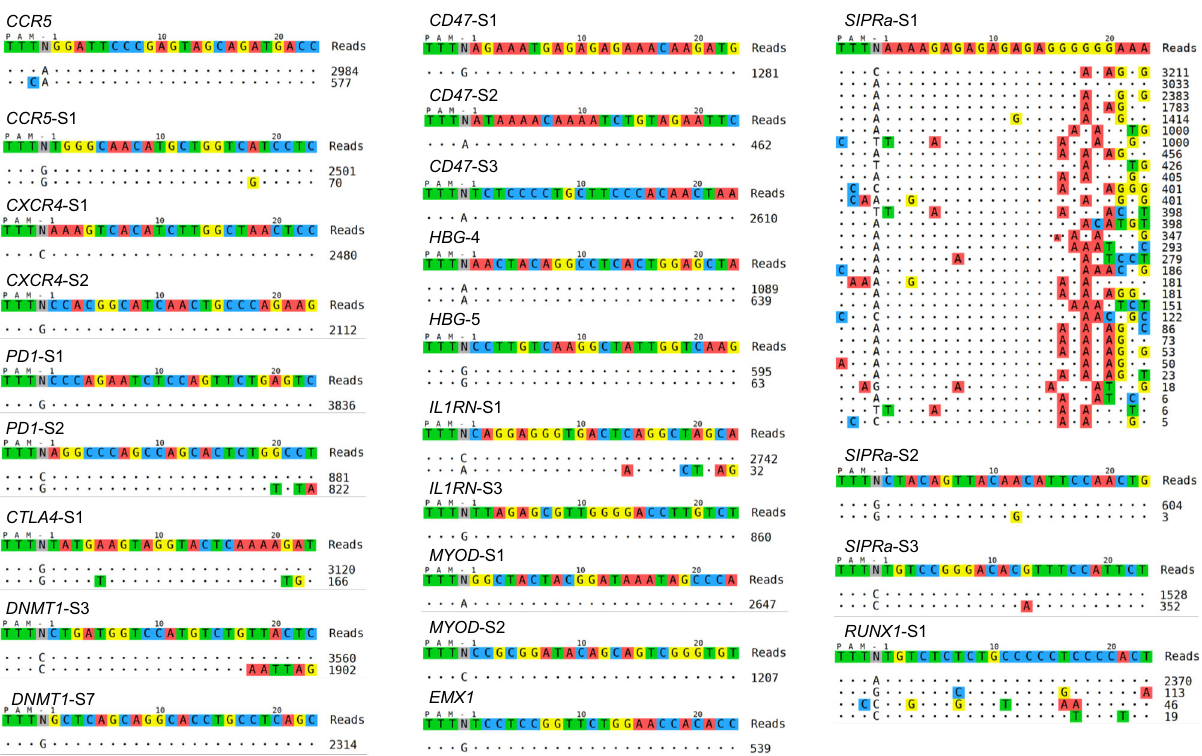
Fig. 4 Tag-seq identi fi es off-target cleavages induced by Cpf1-nuclease in a large-scale manner. Tag-seq pro fi ling the off-target sites induced by As Cpf1 with 23 sgRNA in a single transfection. HEK293T cells were transfected with the donor Tag-oligo, As Cpf1 and a pool mix of 23 sgRNA. Cells were harvested three days after transfection, and genomic DNA was extracted for library construction and then sequenced. All the off-target cleavages of the 23 sites can be parallelly pro fi led by Tag-seq.